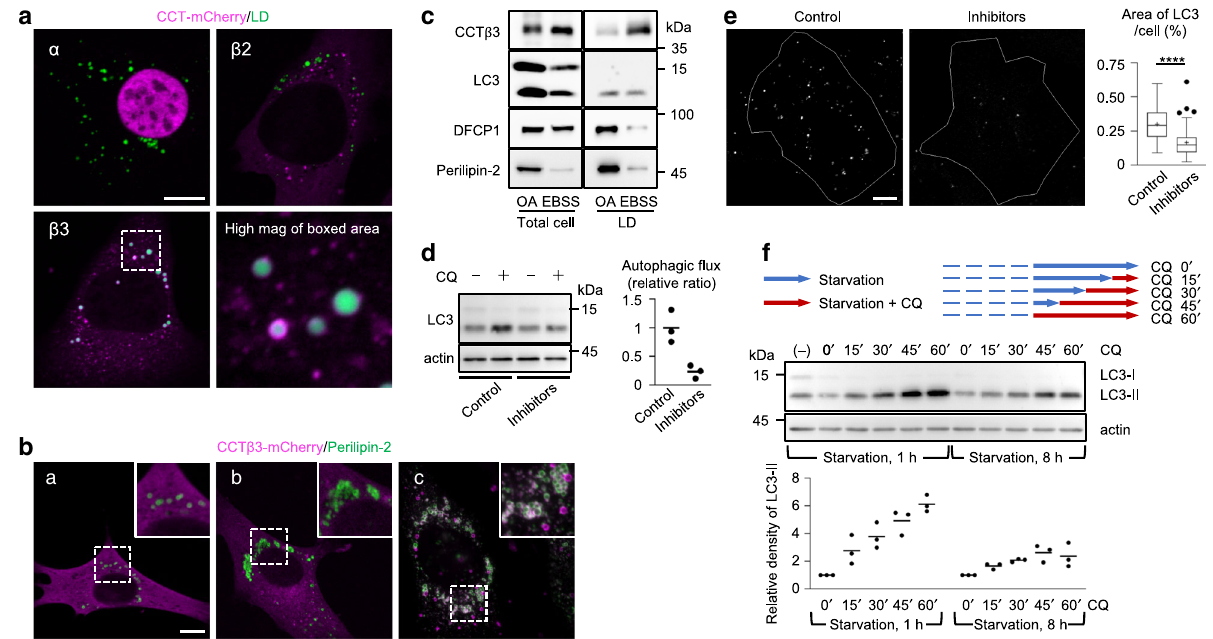
Fig. 5 CCT β 3 in MEFs. a Distribution of mCherry-tagged CCT isoforms (magenta) and LDs (green) in MEFs starved for 8 h. Bar, 10 μ m. b Distribution of CCT β 3-mCherry (magenta) and perilipin-2 (green) in MEFs. Bars, 10 μ m. (a) Regular medium containing OA for 2 days. (b) Regular medium containing OA for 2 days and then in starvation medium for 1 h. (c) Starvation medium containing OA for 8 h. c Western blotting of the total cell lysate and the LD fraction. MEFs overexpressing CCT β 3 were cultured in regular medium containing OA for 8 h (OA) or in starvation medium containing OA for 8 h (EBSS). Twenty micrograms (total cell) and one microgram (LDs) of proteins were loaded. d , e The effect of combined DGAT1 and ACAT inhibition on the autophagic fl ux and the isolation membrane/autophagosome. Cells were cultured for 8 h in starvation medium, with or without a mixture of 20 μ M T863 and 1 μ M avasimibe for the last 2 h. d Autophagic fl ux. A representative result of three independent experiments. e Immunolabeling of endogenous LC3. Bar, 10 μ m. The total area of LC3 puncta in a cell was compared. The center line indicates the median, box boundaries indicate the 25th and 75th percentiles, whiskers are Tukey-type, and the average is marked as + . Pooled data obtained in three independent experiments ( n = 90); **** p < 0.0001 (two-tailed Mann – Whitney test). f The effect of CQ in MEFs cultured in starvation medium for either 2 or 8 h. CQ (20 μ M) was added to the medium for the last 15, 30, 45, or 60 min and the increase of LC3-II was quanti fi ed. A representative result of three independent experiments. Source data are provided as a Source data fi